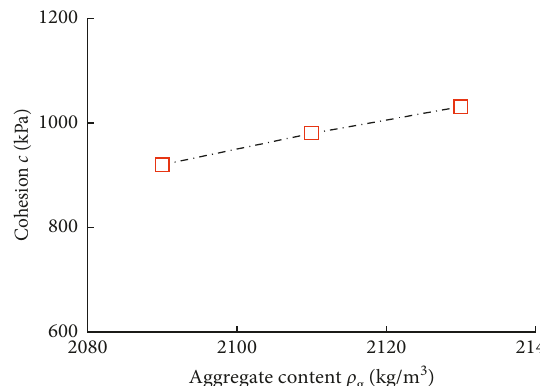
Figure 10: Relation between cohesion and aggregate content.